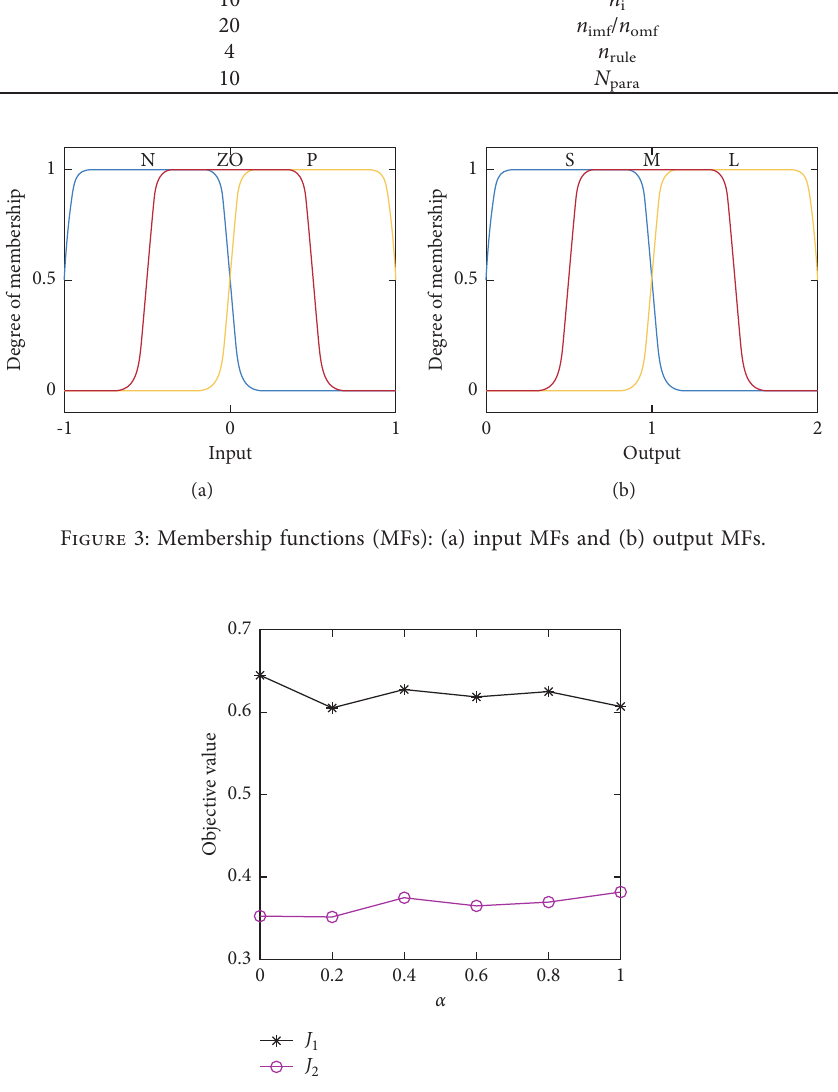
Figure 4: The variation of objective values J